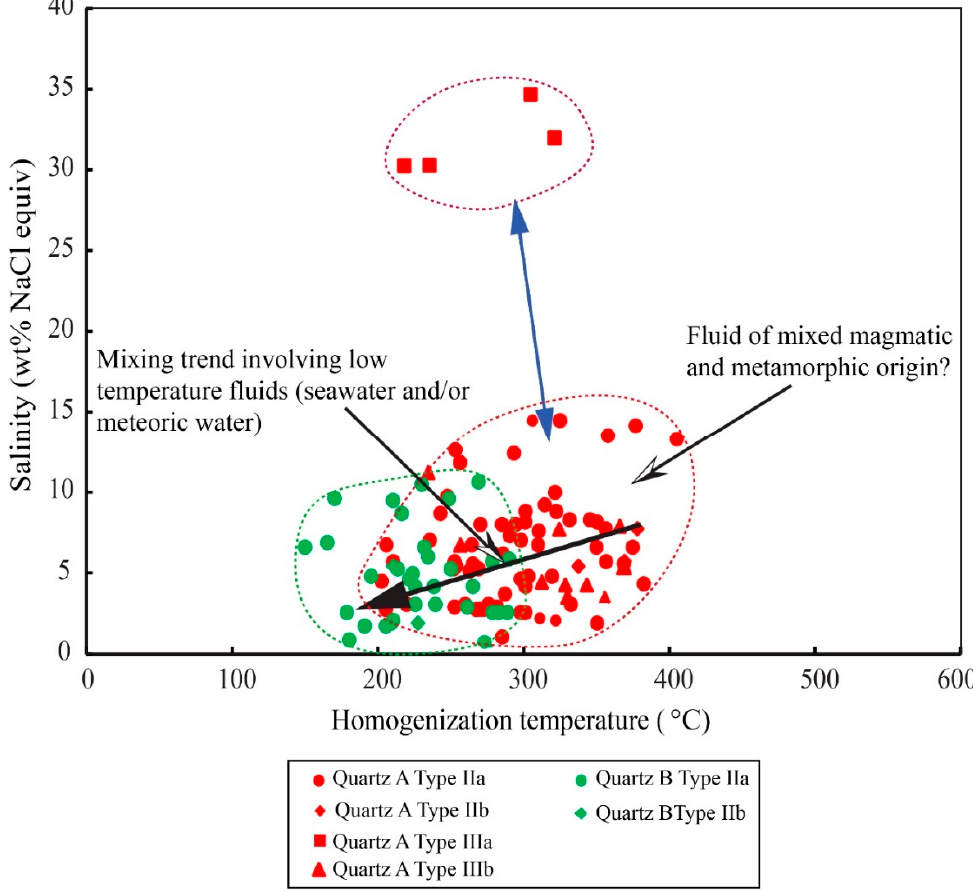
Figure 15. Homogenization temperature versus salinity plot of fluid inclusion data associated with hypogene iron ore enrichment in the Nabeba deposit.